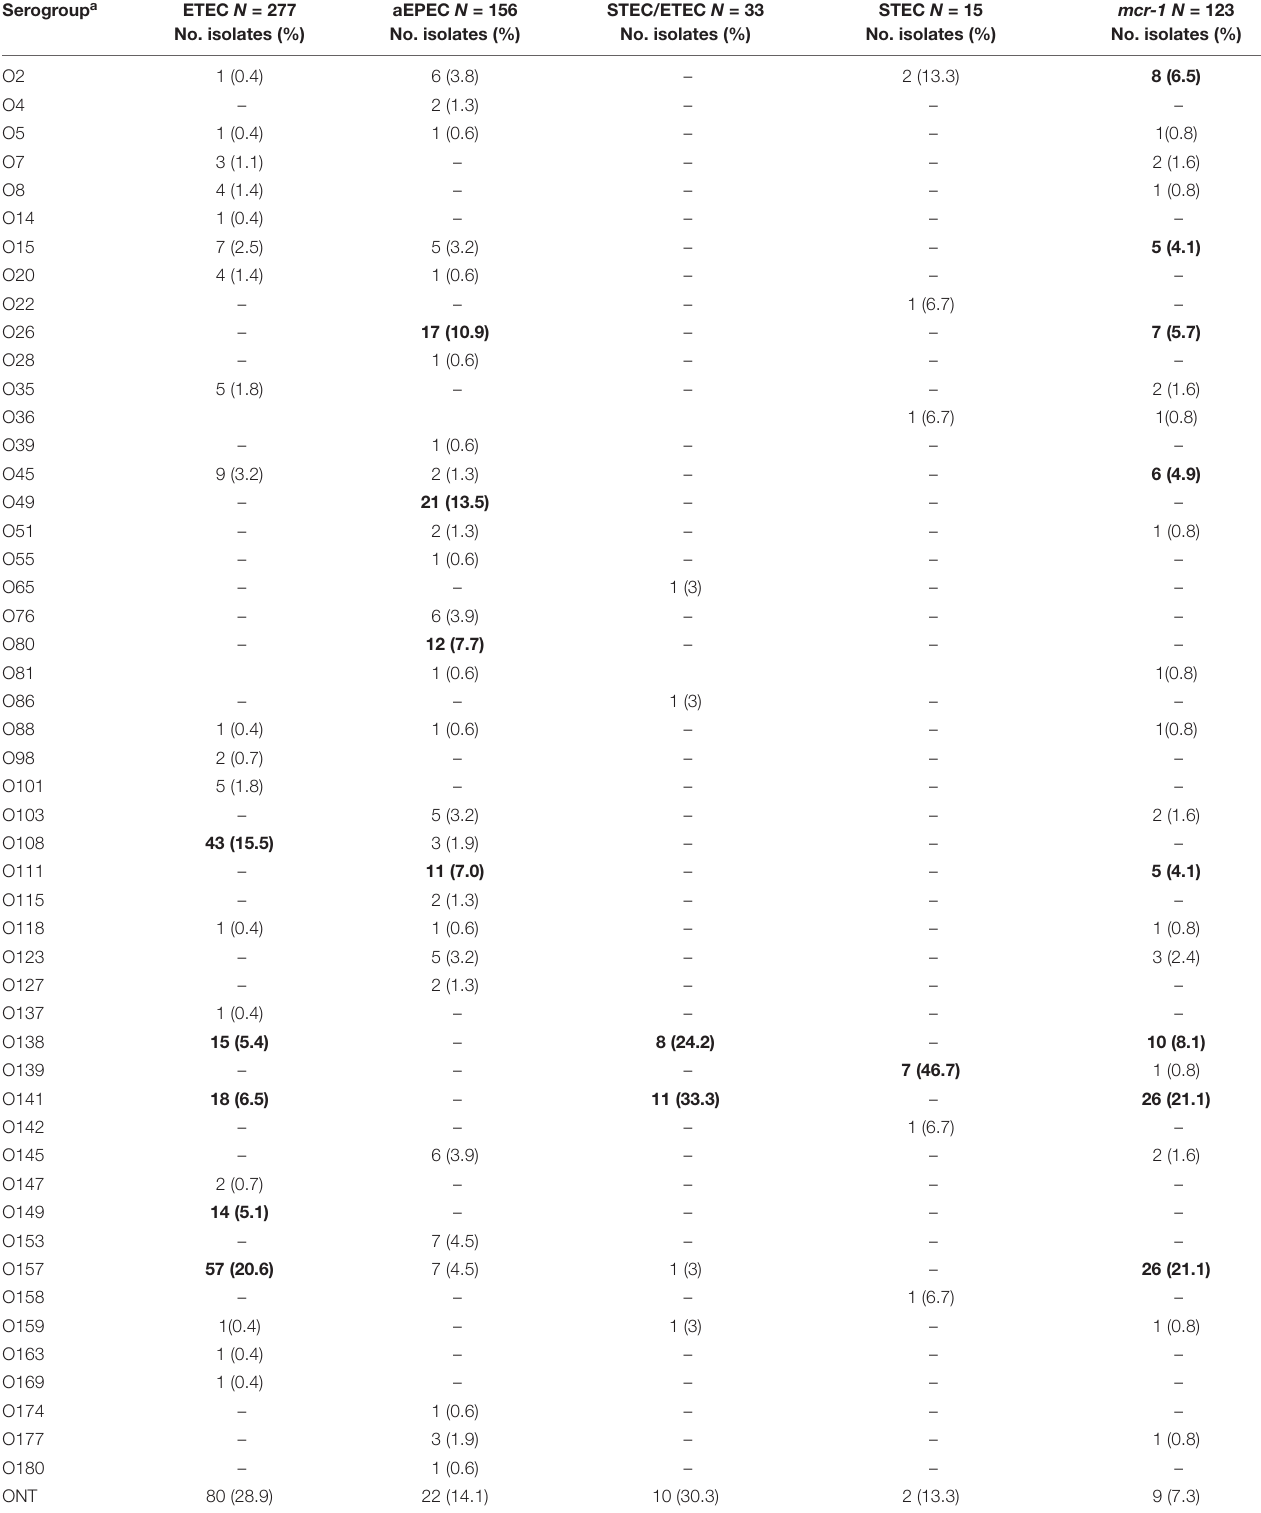
TABLE 1 | Association between serogroups, pathotypes, and presence of mcr-1 gene among the 481 E. coli isolates involved in swine colibacillosis (Spain, 2006–2016). Serogroup a ETEC N = 277 aEPEC N = 156 No. isolates (%) No. isolates